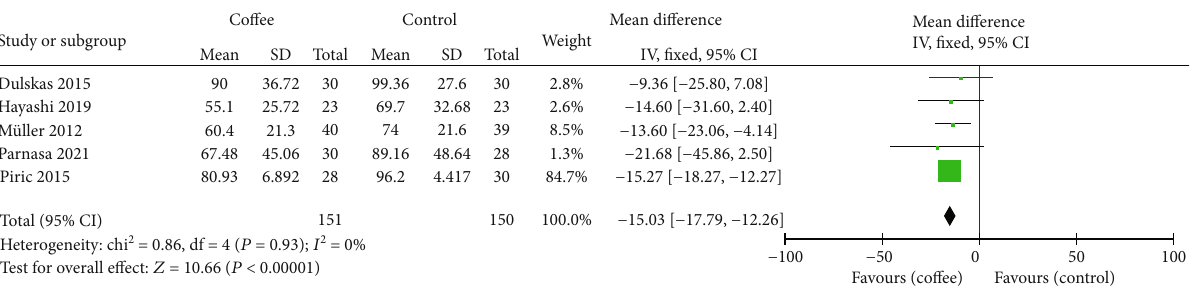
Figure 3: Forest plot of the time to fi rst